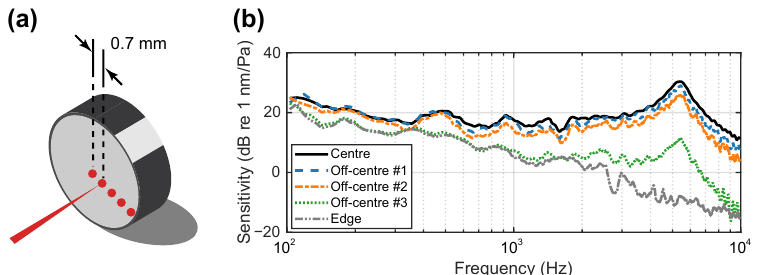
Figure 9. ( a ) Five evaluation points for the laser beam on the membrane specimen-centre, off-centre #1, off-centre #2 and the edge. The interval of the points is about 0.7 mm. ( b ) Sensitivity of the membrane specimen at the five